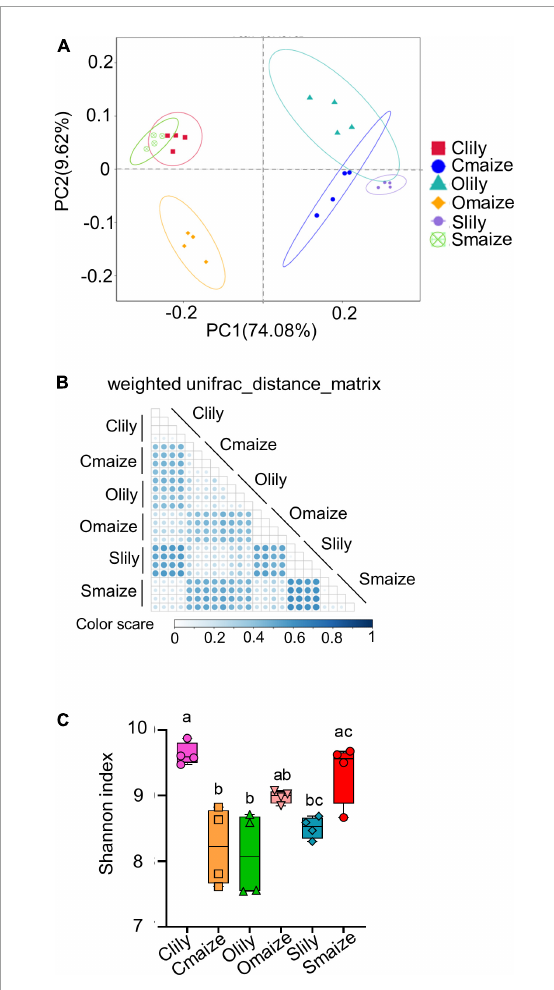
FIGURE1 Geological soil type and plant species are the main factors underlying distinctive variations within rhizosphere bacterial communities. (A) Principal coordinate analysis (PCoA) of the bacterial communities of rhizosphere soil in maize and tiger lily, based on weighted unifrac metrics. n = 4 biological replicates. Clily = tiger lily rhizosphere samples from Cambrian soil; Cmaize = maize rhizosphere samples from Cambrian soil; Olily = tiger lily rhizosphere samples from Ordovician soil; Omaize = maize rhizosphere samples from Ordovician soil; Slily = tiger lily rhizosphere samples from Silurian soil; Smaize = maize rhizosphere samples from Silurian soil. (B) Heatmap of weighted Unifrac distance metrics, used to measure the dissimilarity coefficient between samples. The color scale indicates the difference in species diversity between paired samples; the smaller the value, the smaller the difference. (C) Shannon index of the rhizospheric bacterial communities represents the communities’ diversity in each sample. Means ± SE, n = 4. One-way ANOVA with multiple comparison tests was used for statistical analysis; different letter indicates statistical difference, p ≤ 0.05.